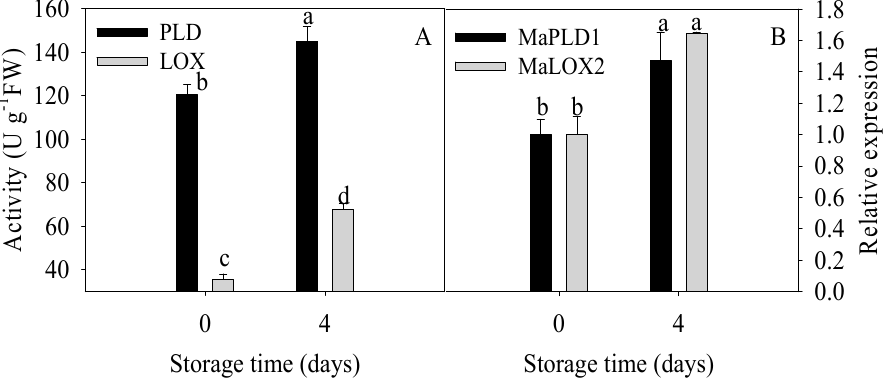
Figure 4. Enzymatic activities ( A ) and relative gene expressions ( B ) of PLD and LOX in banana fruit stored for 0 and 4 d at 6 °C. The data were presented as means ± standard error (n = 3). The means with different letters were significantly different ( p < 0.05).